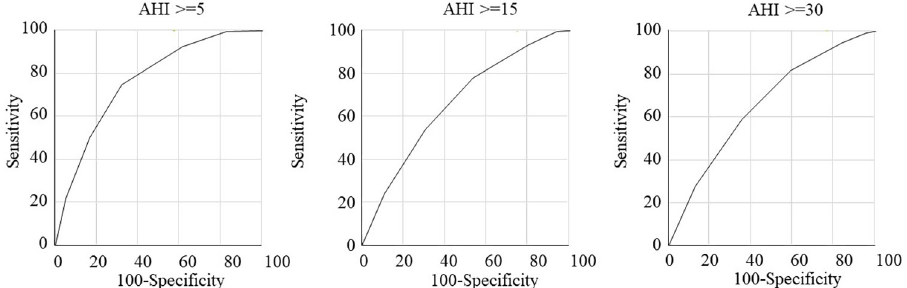
Fig 3. Receiver operating characteristic curves analysis of the SANReSP for all subjects.